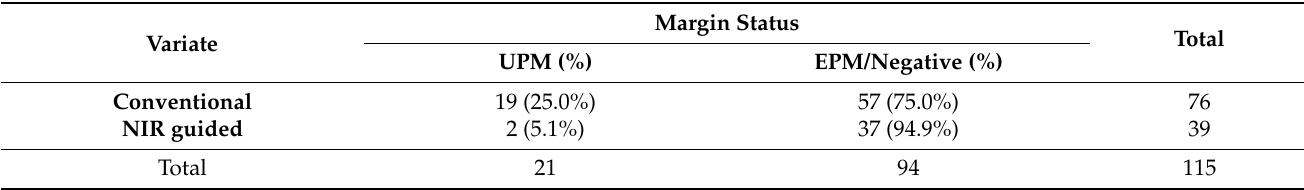
Table 3. Margin status of all patients, split into those treated with conventional surgery and those receiving NIR guidance. UPM = unexpected positive margin, EPM = expected positive margin.